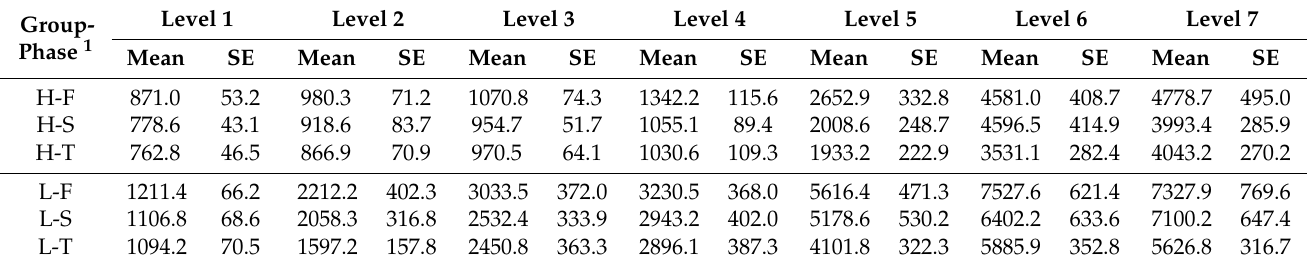
Figure 3. Inverse efficiency scores of the high-efficiency group in the first phase (H-F) and low- efficiency group in the third phase (L-T). More details of H-F and L-T showed in Table 3. Table 3. The mean inverse efficiency scores of the high- and low-efficiency groups (unit: